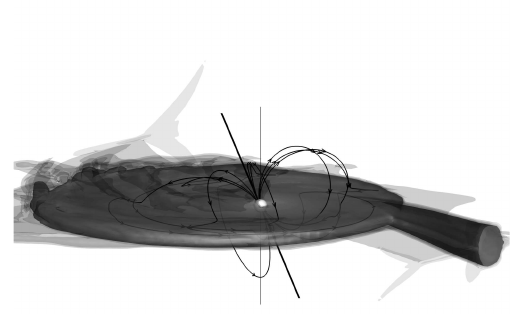
Figure 1: 3D flow structure for the model 1 with B a = 10 5 G. Iso-surface of density (lg ρ = − 4 . 5 in units of ρ ( L 1 )) and magnetic field lines are shown. The ac- cretor’s rotation axis is shown by the thin straight line, magnetic axis — by the bold inclined line.